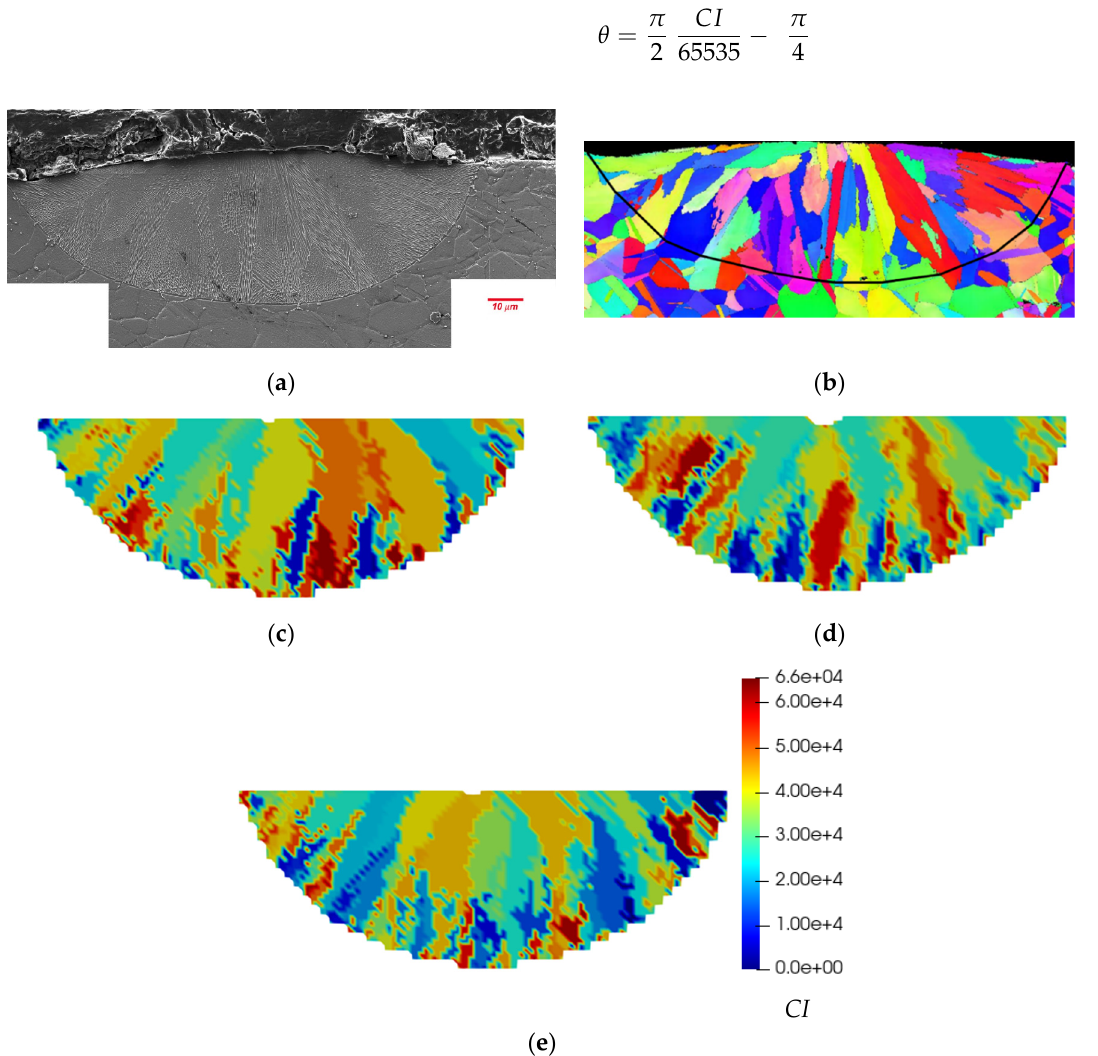
Figure 2. Comparison between experiment [10] ( a , b ) and simulations (3 different YK planes—( c – e )). The black line in ( b ) shows the location of the melt pool boundary.